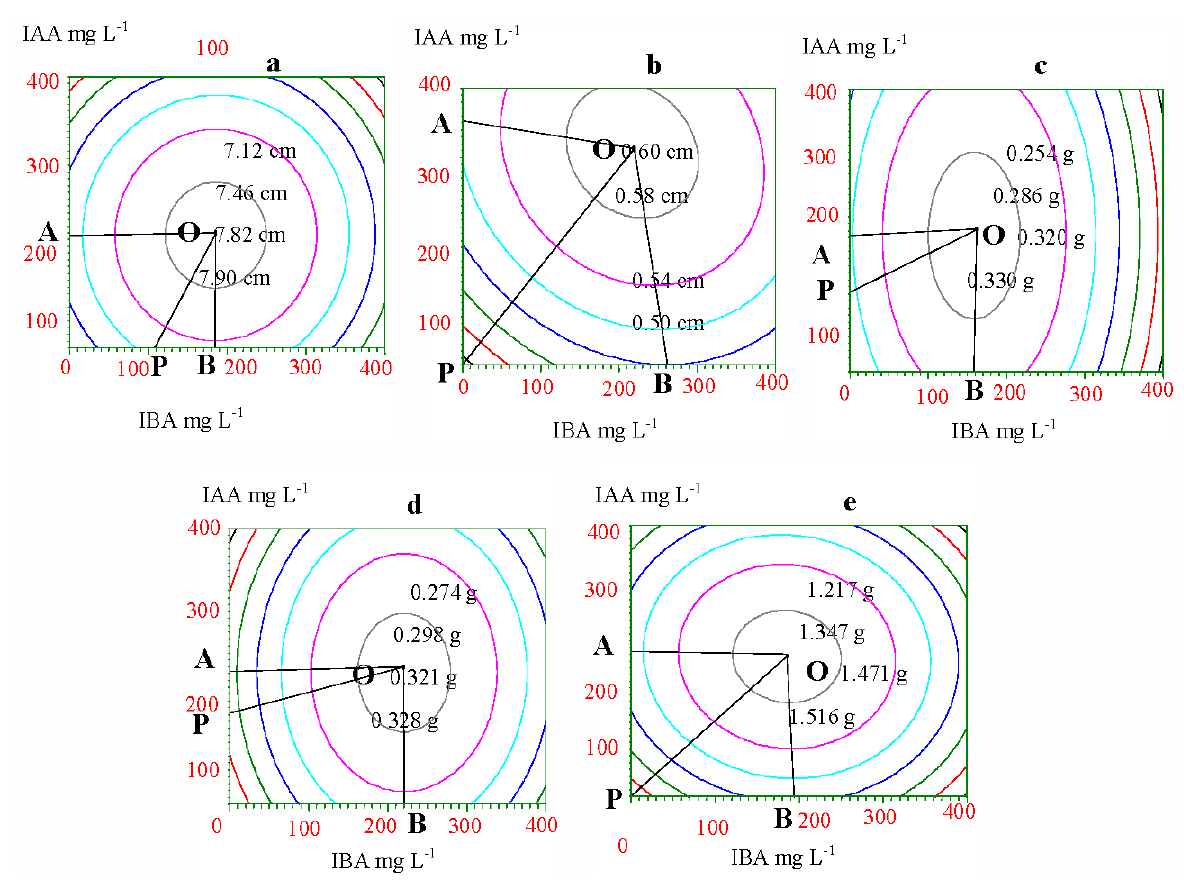
Figure 2. Yield-equality lines of growth and biomass in response to IAA and IBA.